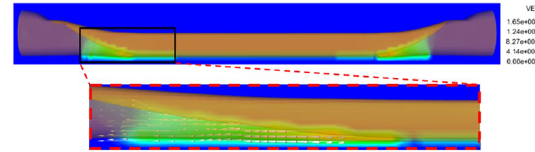
Figure 31 Cloud map of fluid velocity during upper die closing